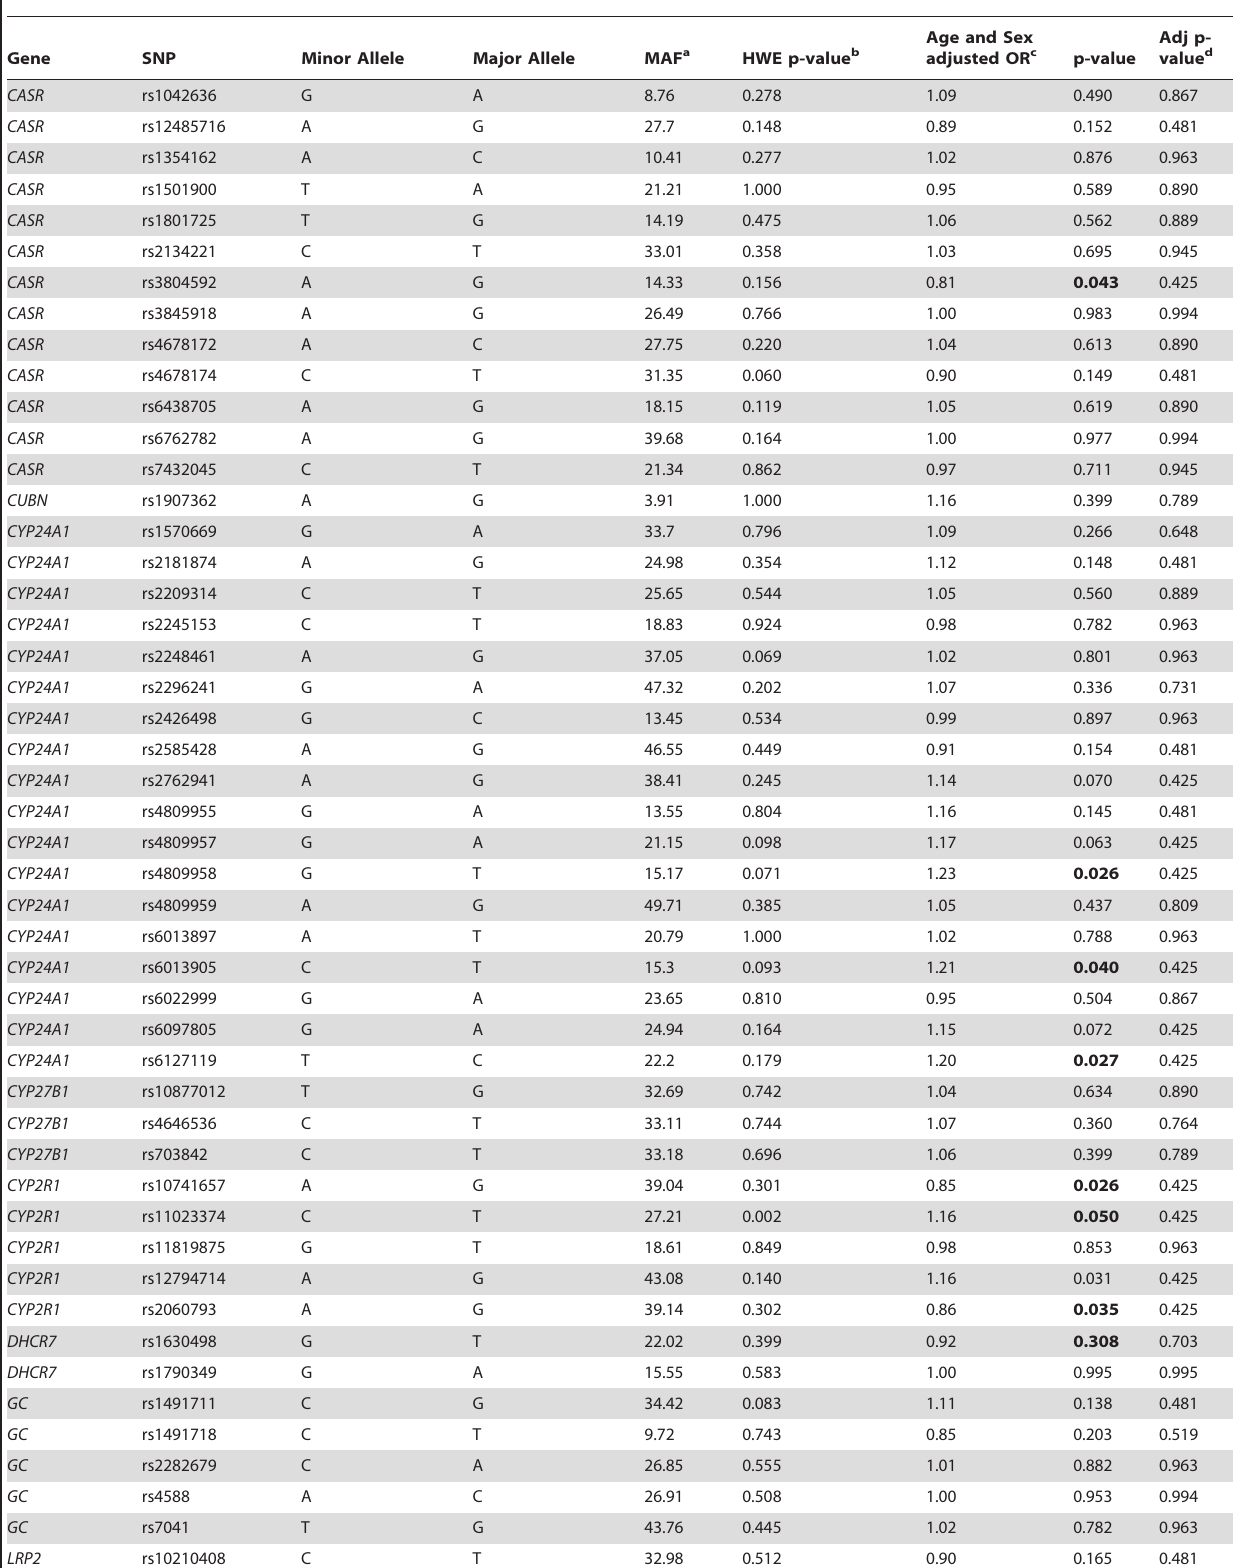
Table 3. Associations between 87 SNPs in vitamin D-related genes and pancreas cancer risk among Ontario cases (n=628) and controls (n=1193) and age and sex adjusted OR using a log additive model